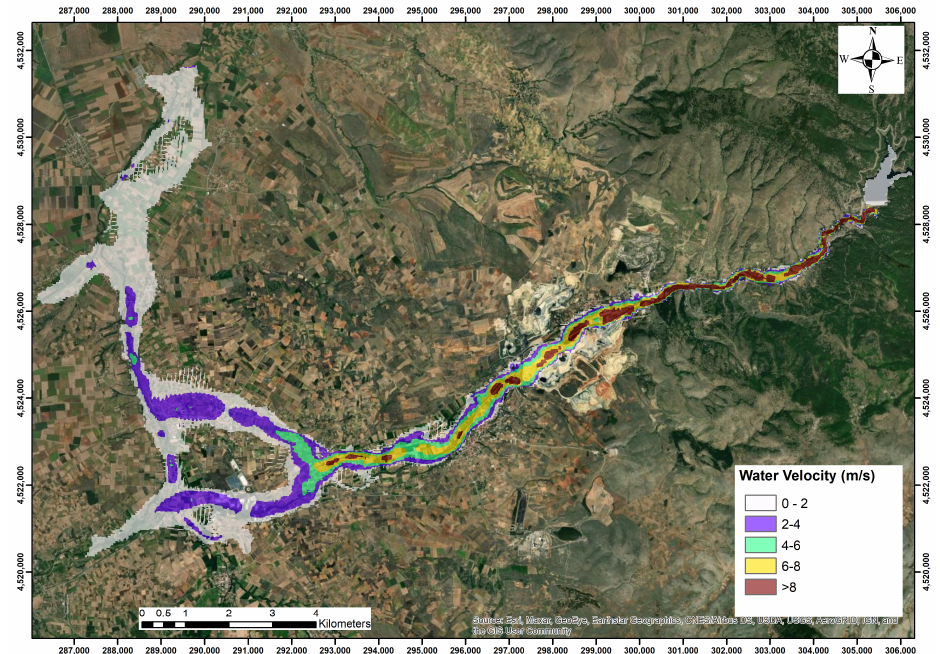
Figure 16. Maximum water velocity and boundaries of inundated area in the case of the piping dam failure. Table 9. Flood severity classes for maximum water velocity and the inundated area per class.